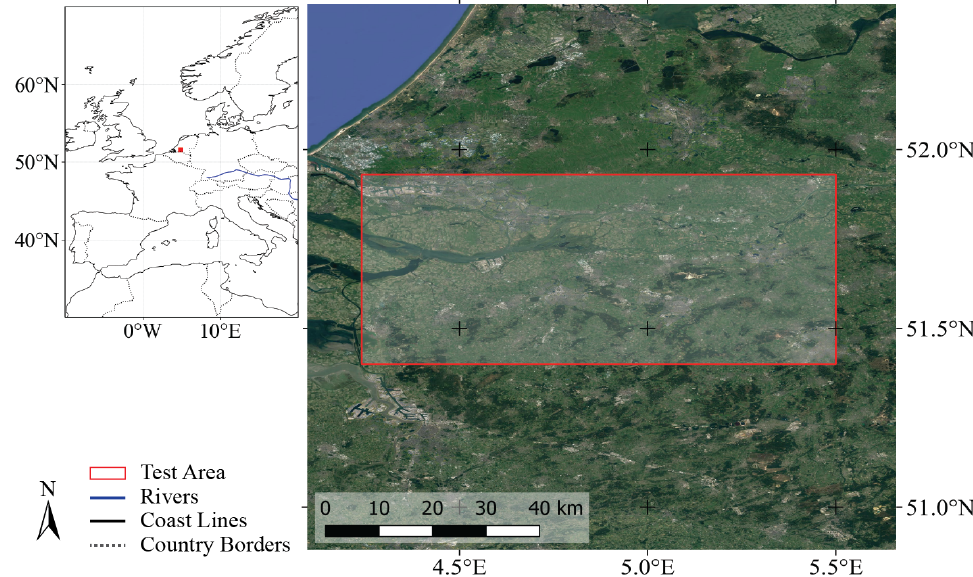
Figure 3. The region of interest with the test area to compare outcomes of equal workflow at different backends. The base image is a Google Earth satellite image (Imagery ©2021, TerraMetrics, Map data